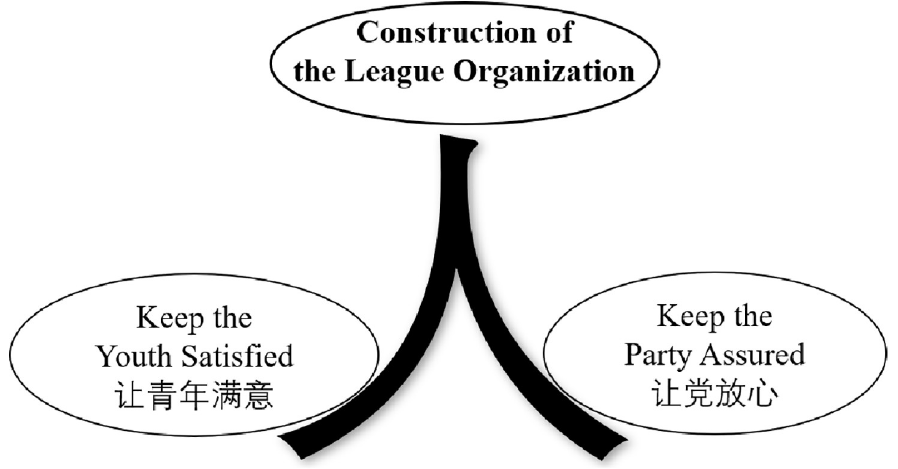
Fig 8. The central committee of the league drives organizational goals with organization